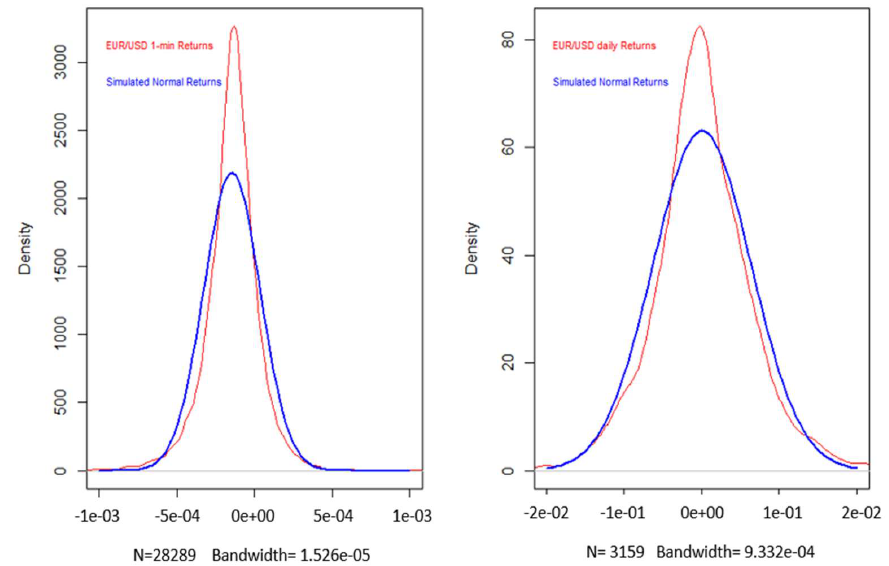
Figure A1. Kernel density estimates for 1 min returns ( left ) and daily returns ( right ). The p -values for both returns series are less than 5% and this allows the rejection of the null hypothesis that a unit root is present in the series. Therefore, both return series are stationary and the order of the parameter d in the ARIMA( p , d , q ) model for both series is equal to 0.